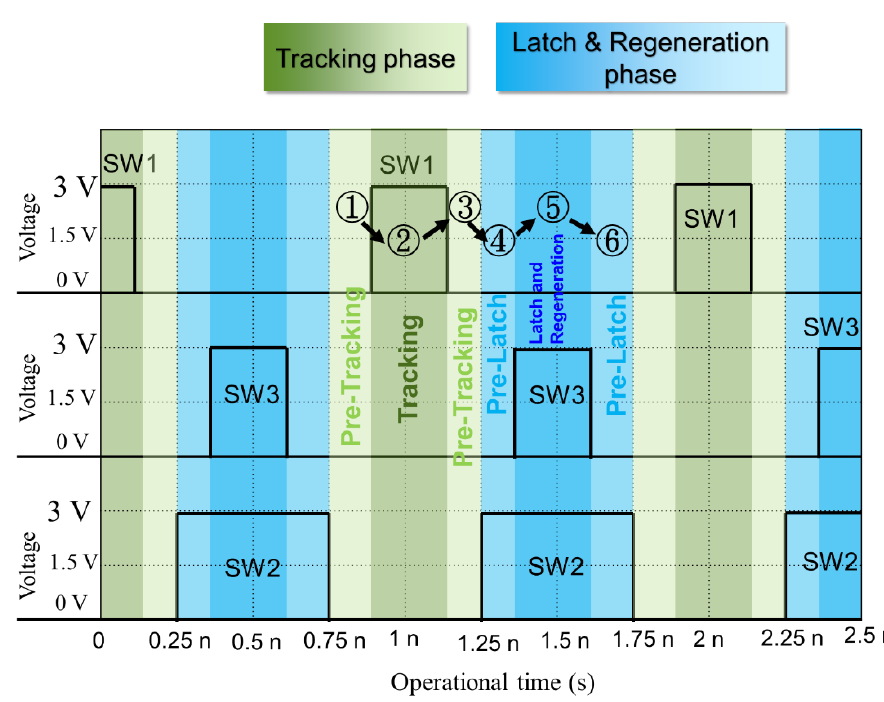
Figure 11. The time sequence of proposed dual offset cancellation comparator.